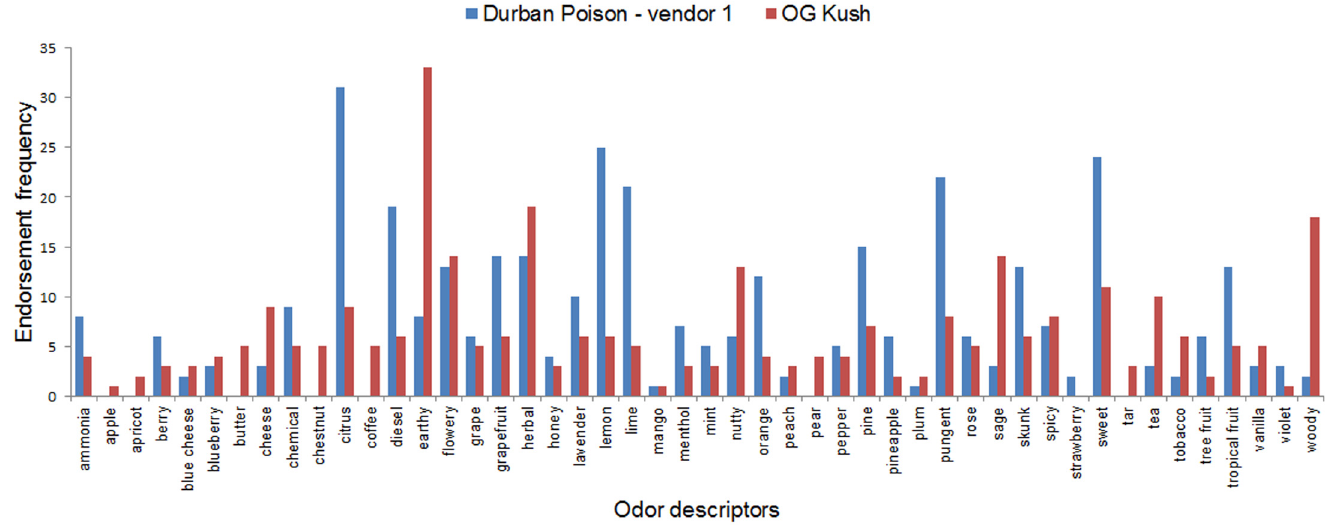
Fig 3. Aroma profiles for two of the strains tested in this study. Frequency counts of each odor descriptor.